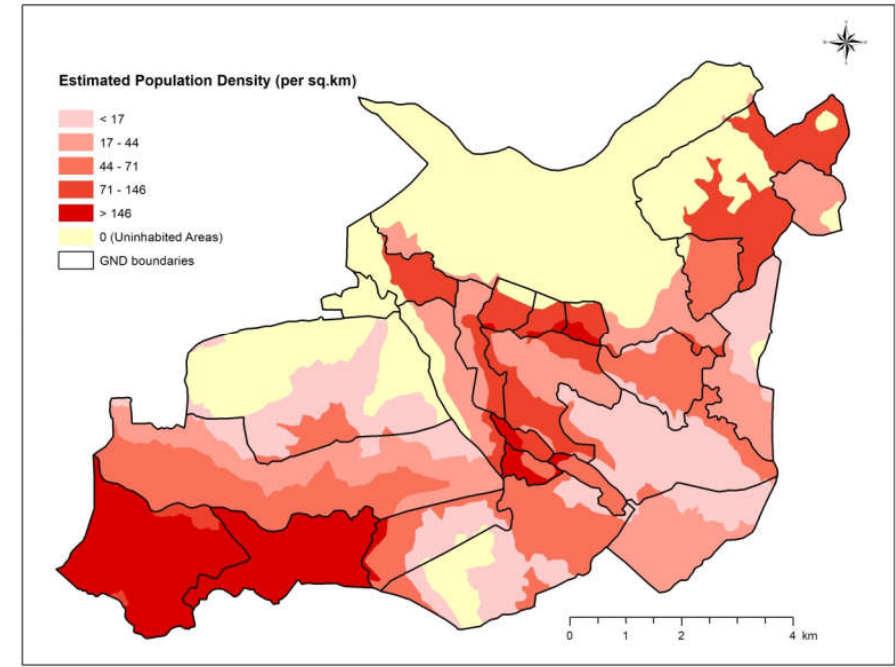
ISPRS Int. J. Geo-Inf. 2019 , 8 , 166 Figure 8. Population estimation using the altitude-based dasymetric mapping. Figure 8. Population estimation using the altitude-based dasymetric mapping.